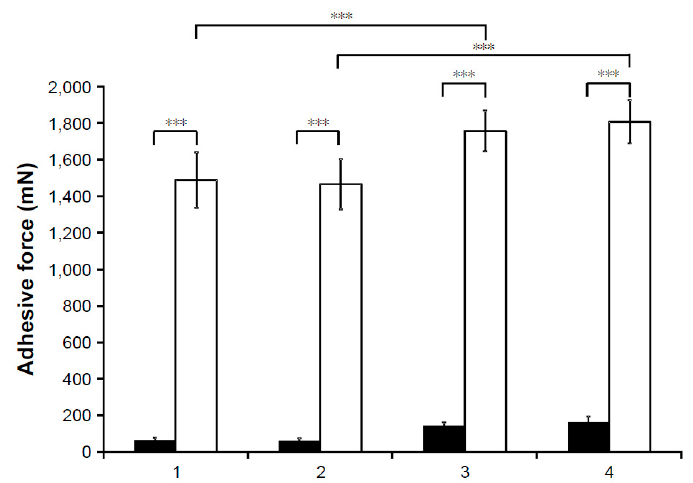
Figure 5. Results of tensile test with (white columns) and without (black columns) mucin. (1, with HPBCD; 2, with HPGCD; 3, with HPBCD and ZnHA–ZnGlu; 4, with HPGCD and ZnHA–ZnGlu) [24] (*** p ≤ 0.001).